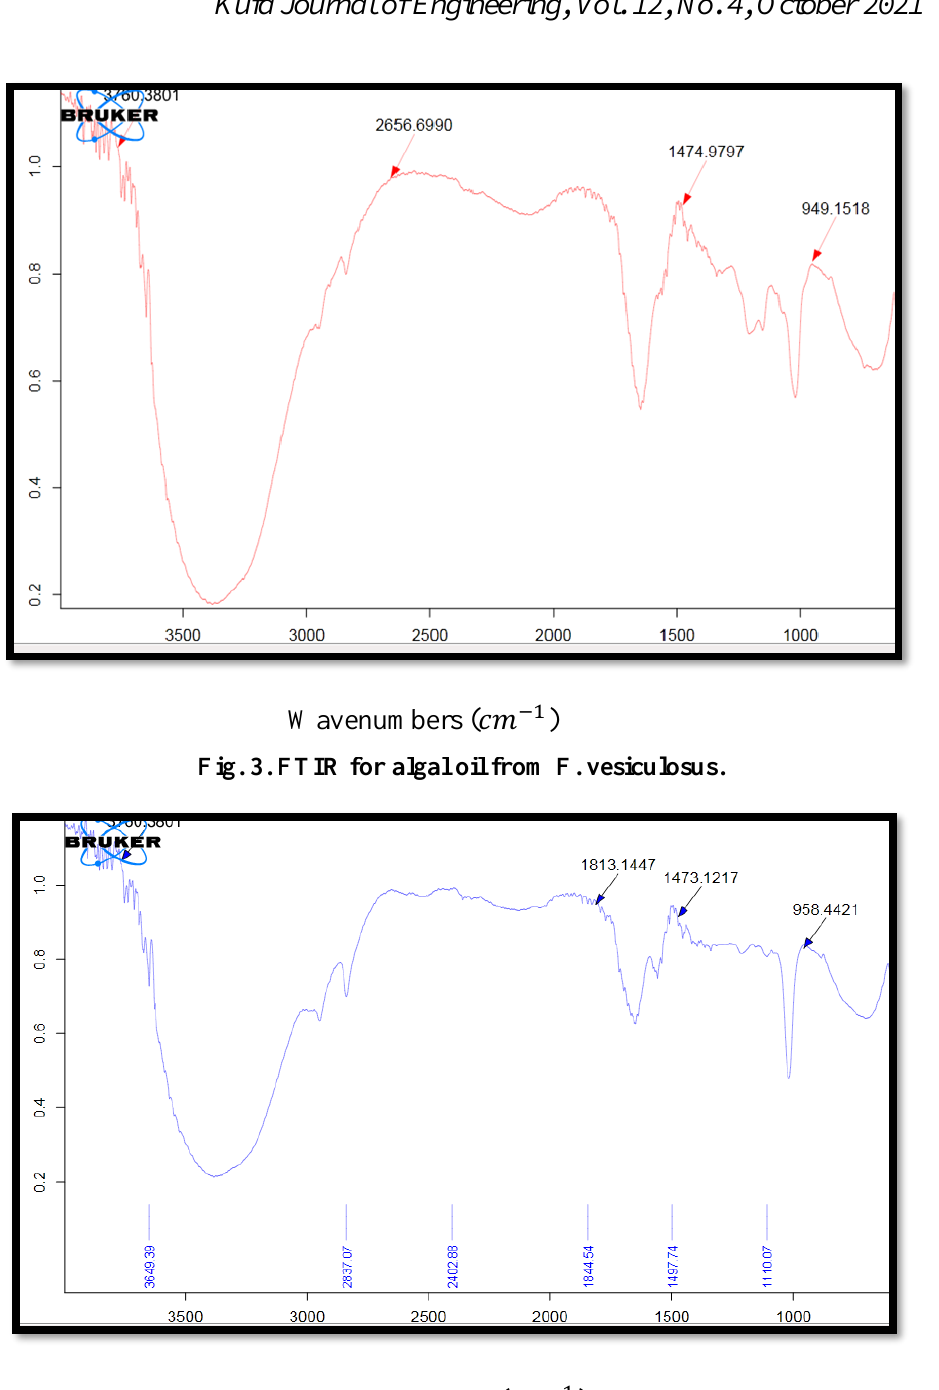
Fig. 4. FTIR for algal oil from C.